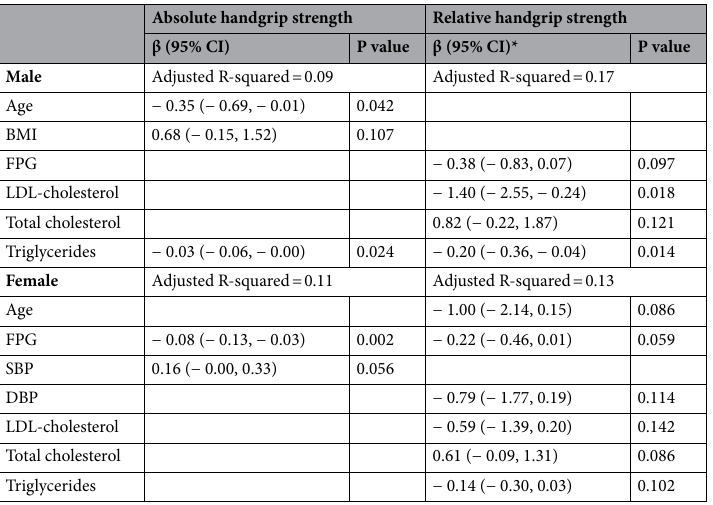
Table 4. Cumulative association of cardiometabolic risk factors with handgrip strength by sex. BMI body mass index, FPG fasting blood glucose, SBP systolic blood pressure, DBP diastolic blood pressure, LDL low- density lipoprotein. *β (95% CI) were multiplied by